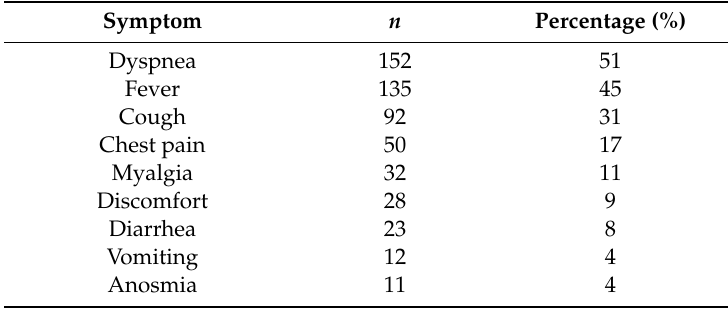
Table 2. Main prehospital functional symptoms collected from advanced life support (ALS) prehospital medical reports.